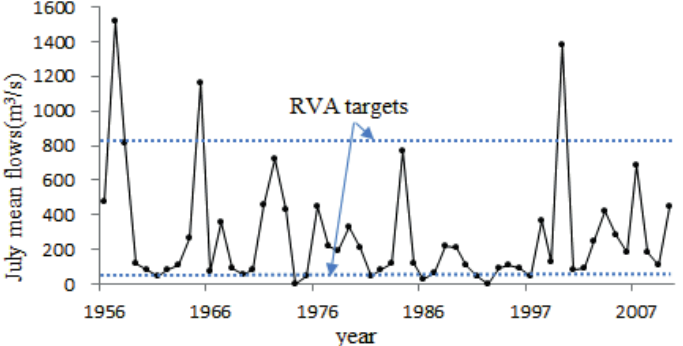
Fig. 2 Variation of July mean flow pre and